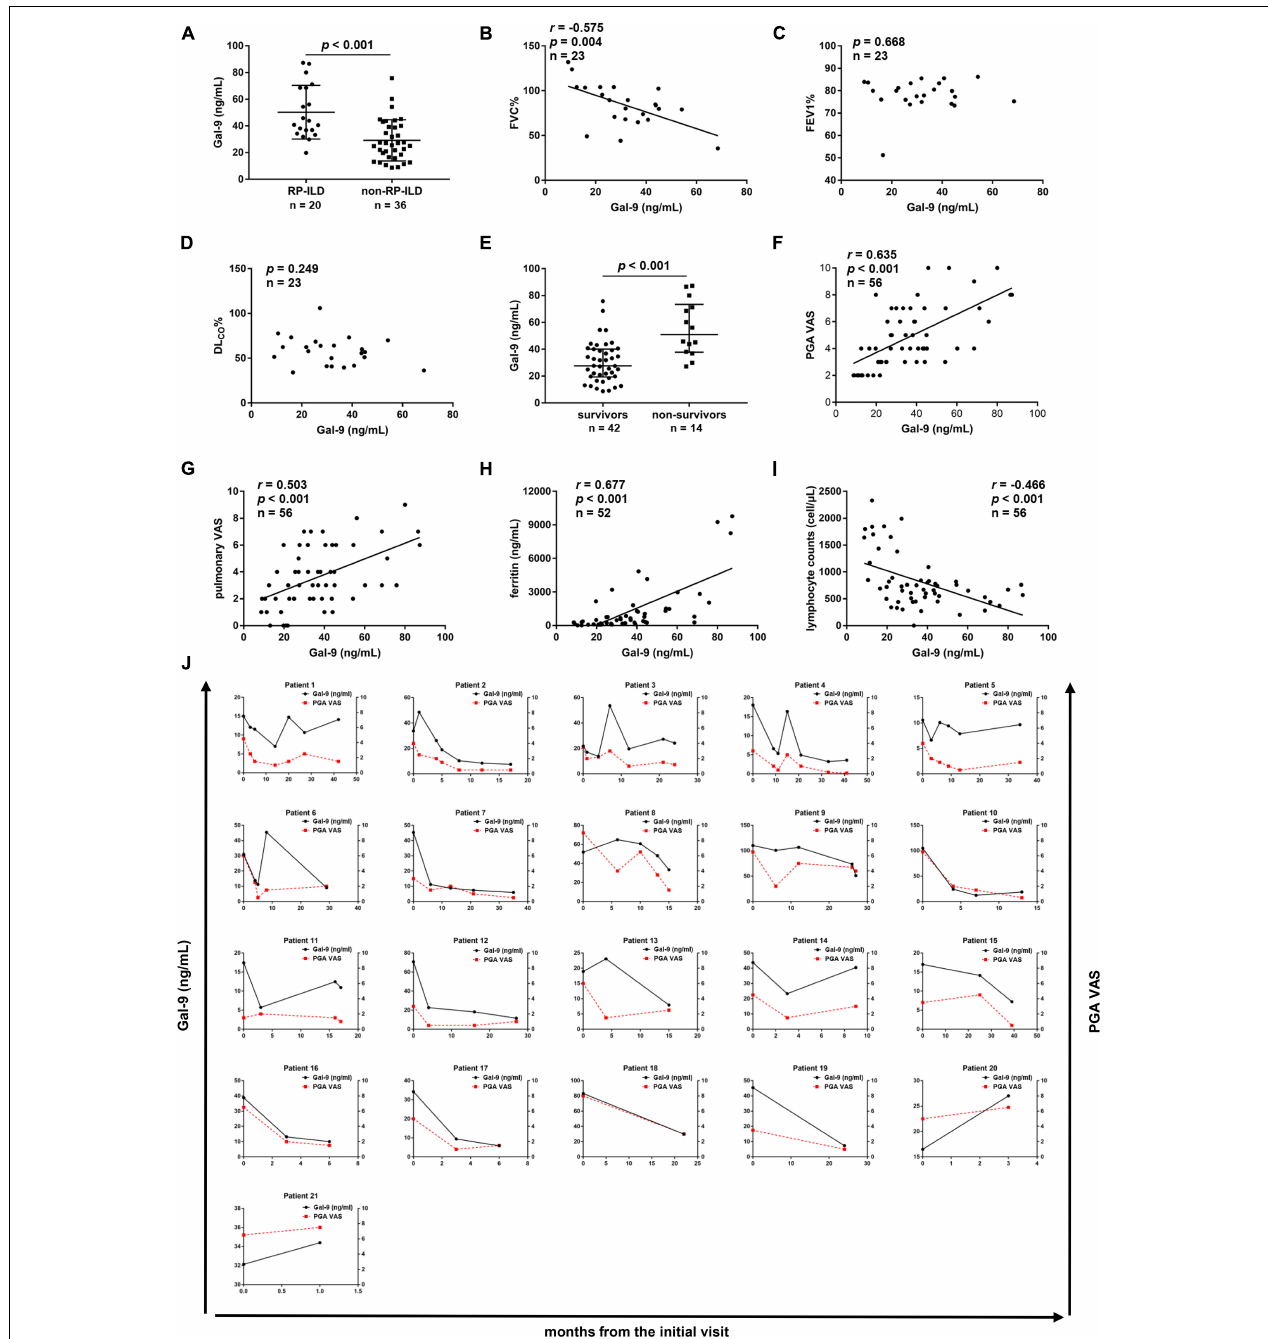
FIGURE 2 | Correlations between serum galectin-9 (Gal-9) levels and clinical features in anti- melanoma differentiation-associated gene 5 (MDA5)-positive patients. (A) Serum levels of Gal-9 in patients with rapidly progressive interstitial lung disease (RP-ILD) and patients with non-RP-ILD. (B–D) Correlations between serum Gal-9 levels and pulmonary function impairment parameters. (B) Serum Gal-9 levels were correlated with forced vital capacity (FVC)% by Pearson’s correlation analysis. (C) Serum Gal-9 levels were not correlated with forced expiratory volume in 1s (FEV1)% by Spearman’s correlation analysis. (D) Serum Gal-9 levels were not correlated with diffusing capacity of carbon monoxide (DLco)% by Pearson’s correlation analysis. (E) Serum levels of Gal-9 in patients who survived and patients who died. (F,G) Correlations between serum Gal-9 levels and physician’s global assessment (PGA) visual analog scale (VAS) scores (F) and pulmonary VAS scores (G) by Spearman’s correlation analysis. (H) Serum levels of Gal-9 were correlated with ferritin levels by Spearman’s correlation analysis. (I) Serum levels of Gal-9 were correlated with lymphocyte counts by Spearman’s correlation analysis. (J) Longitudinal changes in serum levels of Gal-9 and PGA VAS scores over time in 21 anti-MDA5-positive patients. The serum levels of Gal-9 were significantly correlated with PGA VAS scores using the generalized estimating equation model. Horizontal bars indicate median with interquartile range.